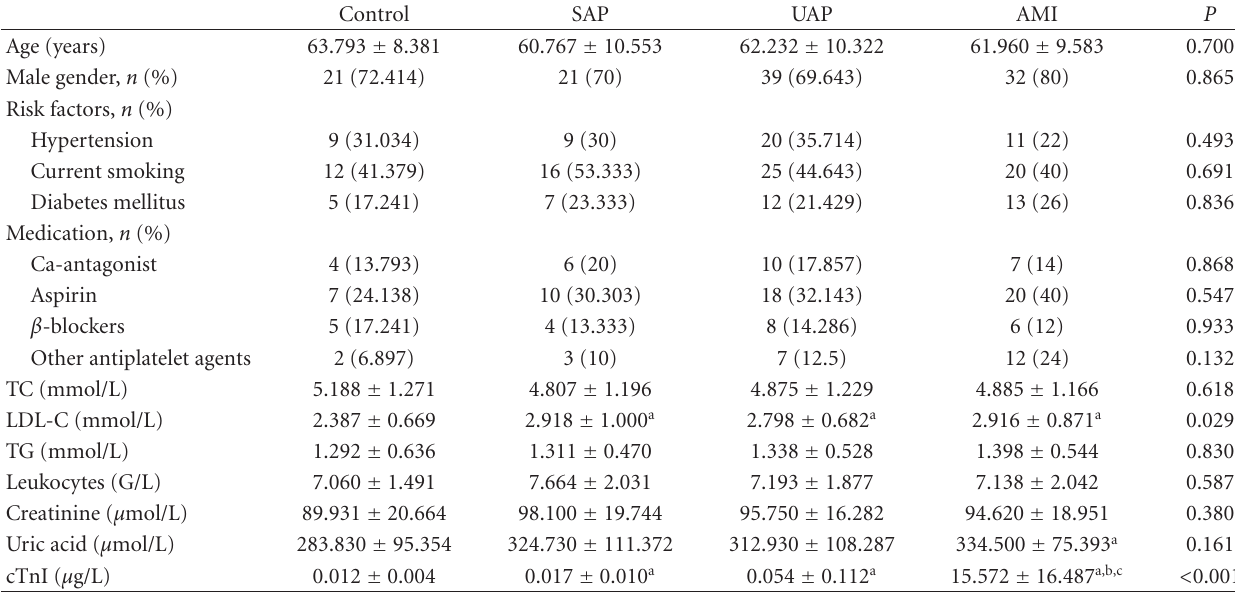
Table 1: Clinical characteristics of patient